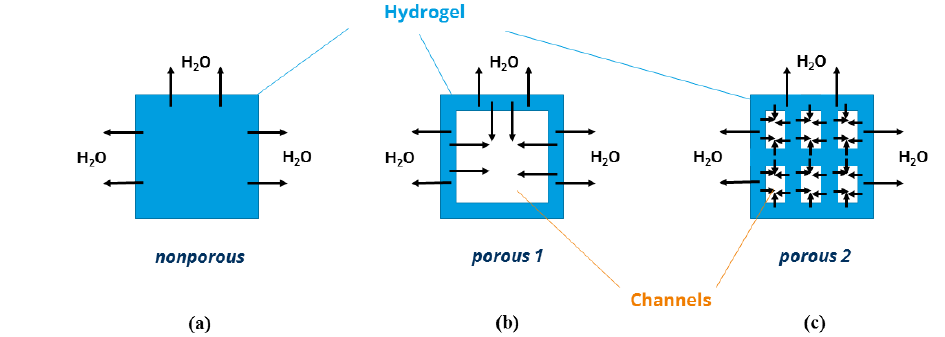
Figure 4. Schematic illustration of the water release in nonporous and porous PNIPAAm samples.